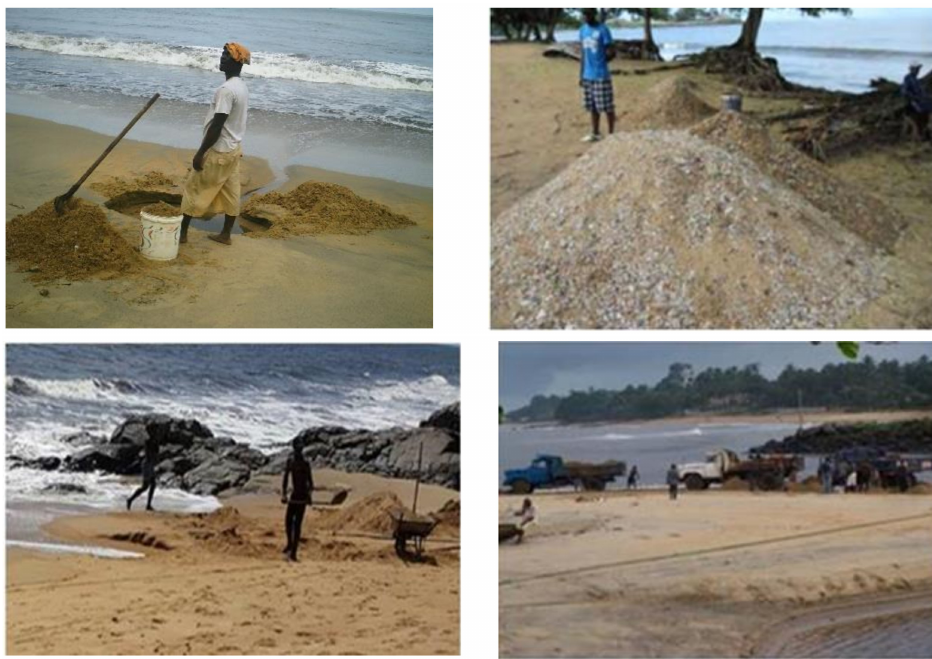
Figure 23. Artisanal and industrial sand extraction on the Kribi coast. (Credit: Mbevo, May 2019, Tchindjang, March 2013). This photo board confirms the significant extraction of sand on the Kribi